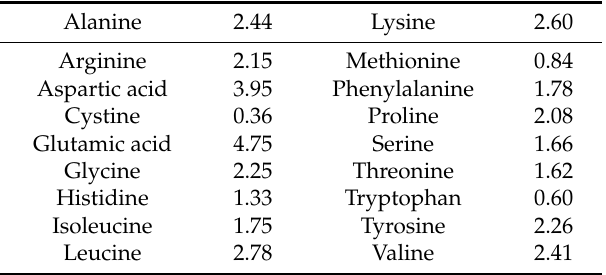
Table 2. Amino acid profile (g / 100 g DM) of BSFL reared in brewer’s by-product.